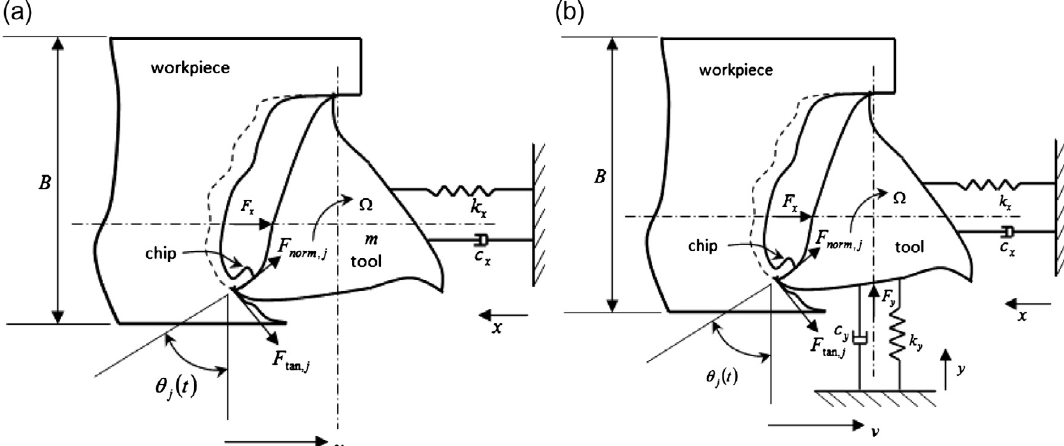
Figure 1. Mechanical model of milling tool with indications of dynamic ( F tan, j ( t ), F norm, j ( t ), F x ( t ), h j ( t )), process ( v , B , X ) and constant ( k x , k y , c x , c y , m etc.) parameters. (a) 1DOF model and (b) 2DOF